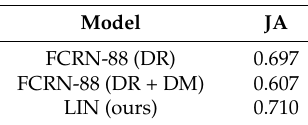
Table 3. JA of frameworks on ISIC 2017 validation set.